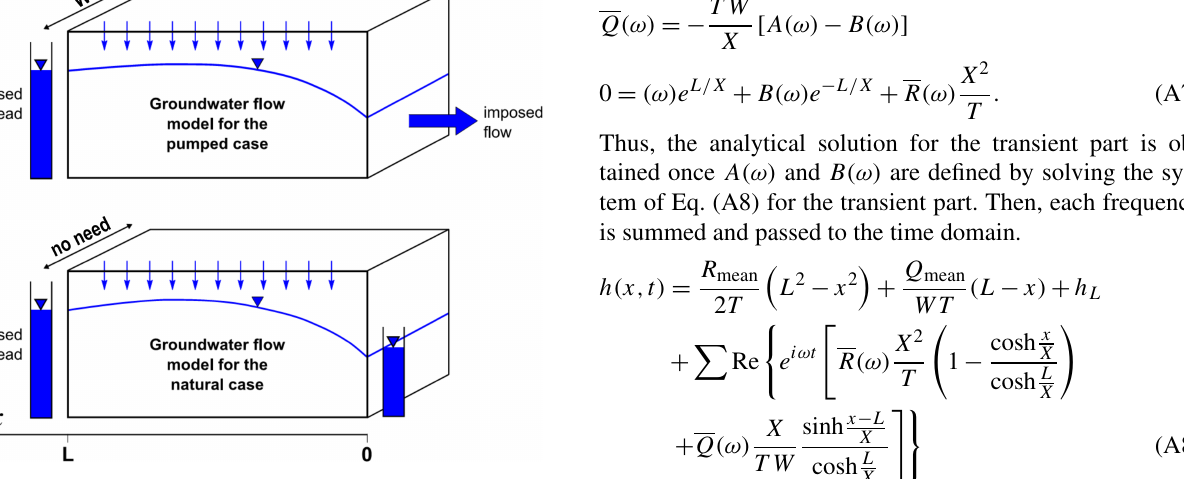
Figure A1. Scheme of the analytical 1D groundwater model. Hy- draulic head is variable along the x axis. Transmissivity T and stora- tivity S are constant. Note that we consider an aquifer of uniform thickness with confined behavior under the Dupuit assumption so that the aquifer thickness does not matter in the model. (a) With boundary conditions corresponding to the pumping case. (b) With boundary conditions corresponding to the natural case (the solution is independent of the model width W